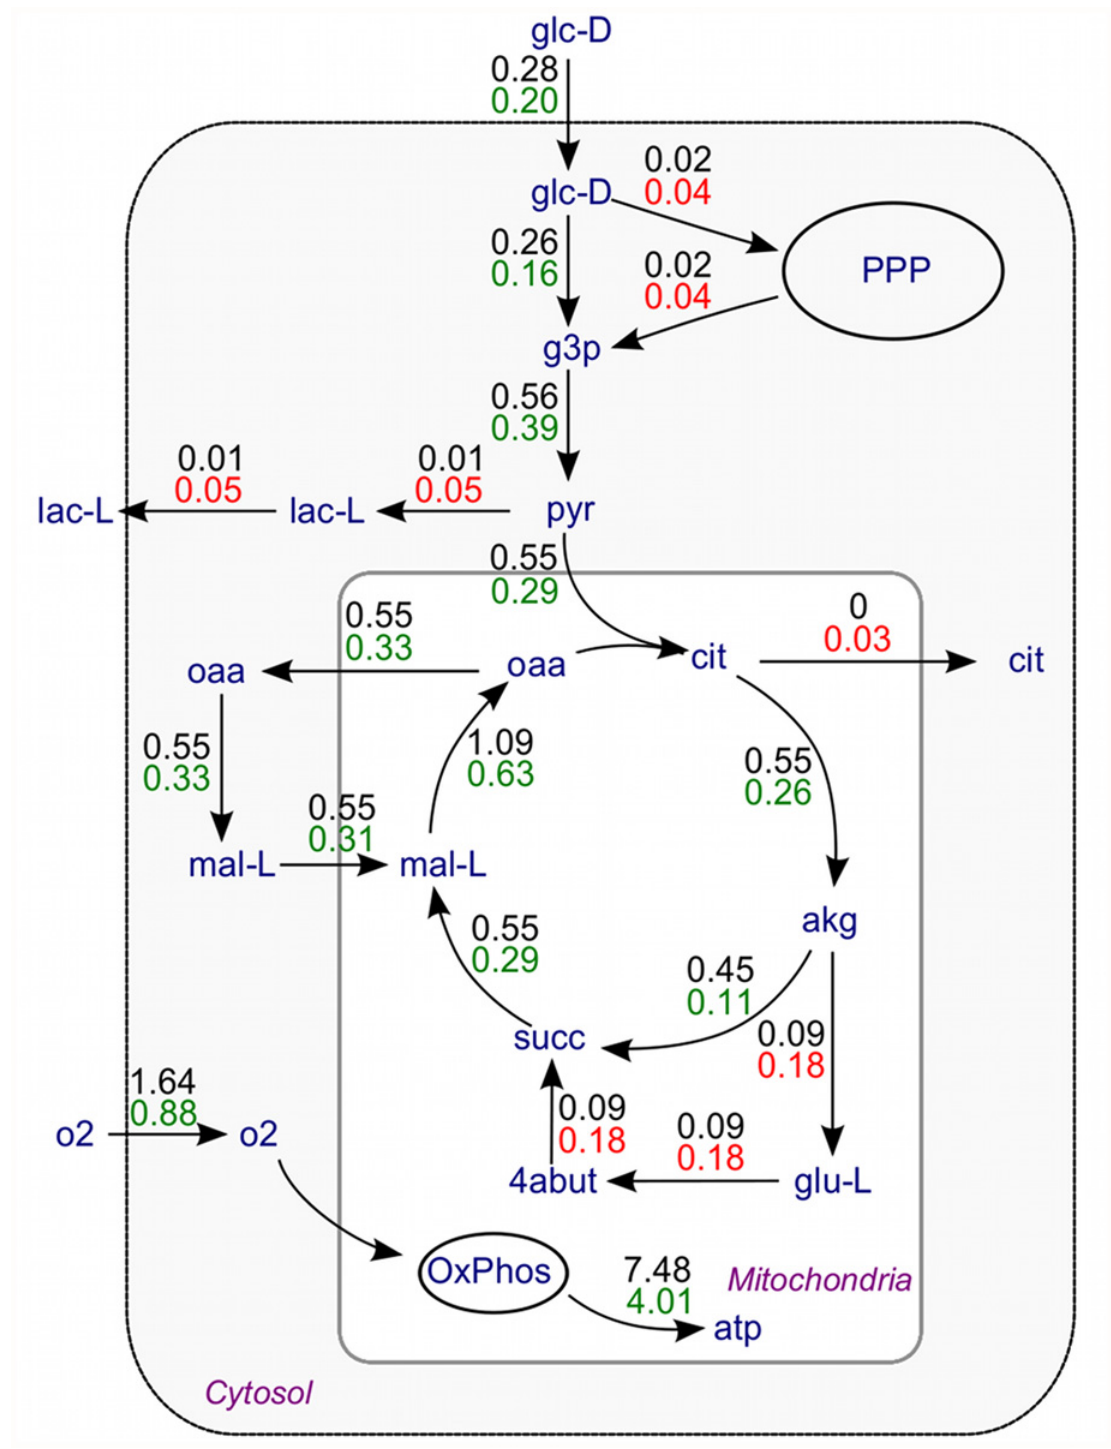
Fig 4. Flux distribution in a healthy brain and during AD.